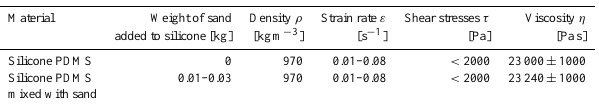
Table A2. Physical properties of silicone putty used in the study presented